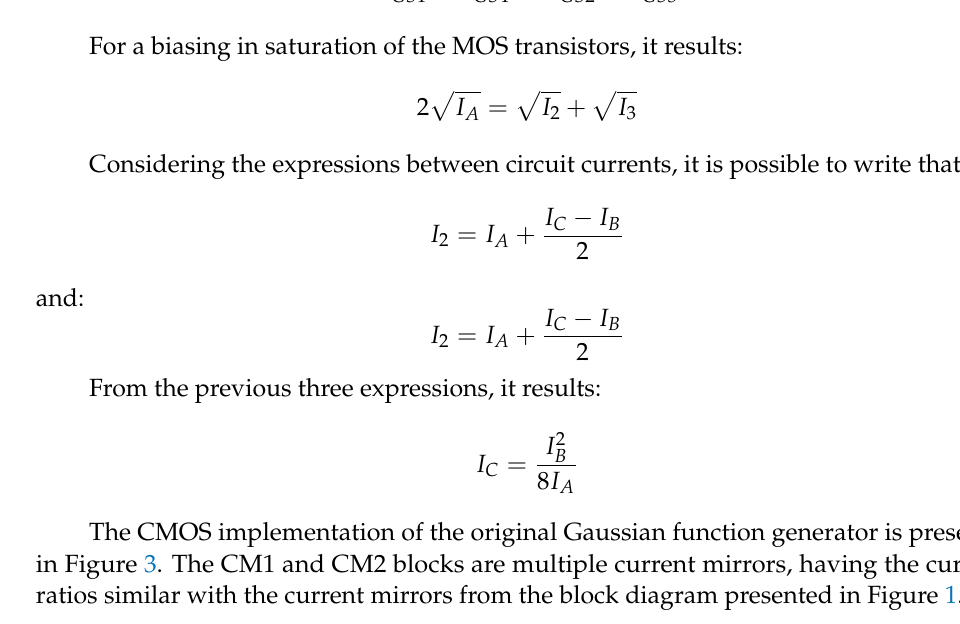
gate-source voltage of the MOS transistors from Figure 2